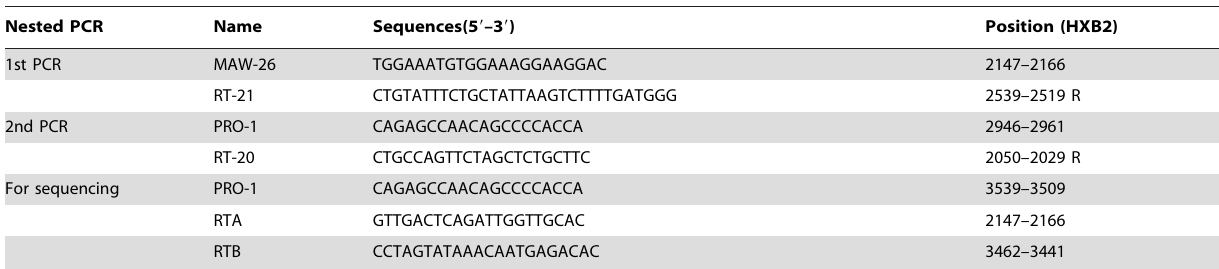
Table 1. Primers used in this study.